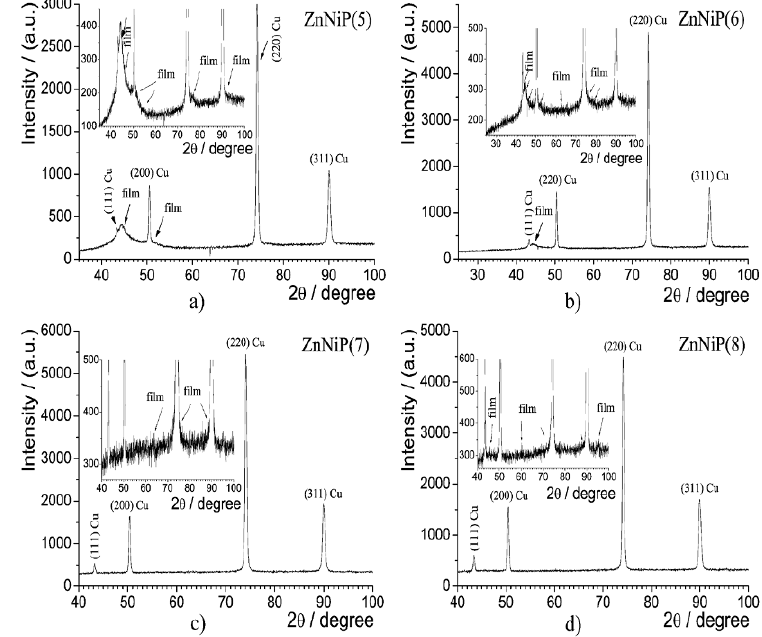
Figure 4. XRD pattern of electrodeposited Zn-Ni-P thin films: a)ZNP(5); b)ZNP(6); c)ZNP(7); d)